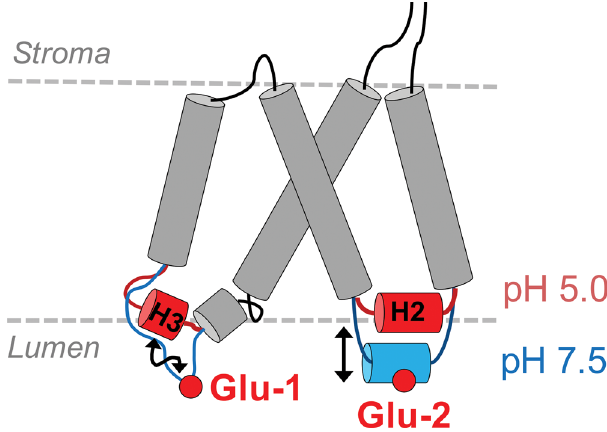
Fig. 5 Illustration of the pH switch of PsbS. Schematic illustration of the pH-dependent movement of helix H2 and folding of helix H3 in WT PsbS at low pH. Protonation of Glu-2 results in repositioning of amphipathic helix H2 from the aqueous phase to the membrane phase, while protonation of Glu-1 causes the H3 element to switch from a loop segment into a 3 10